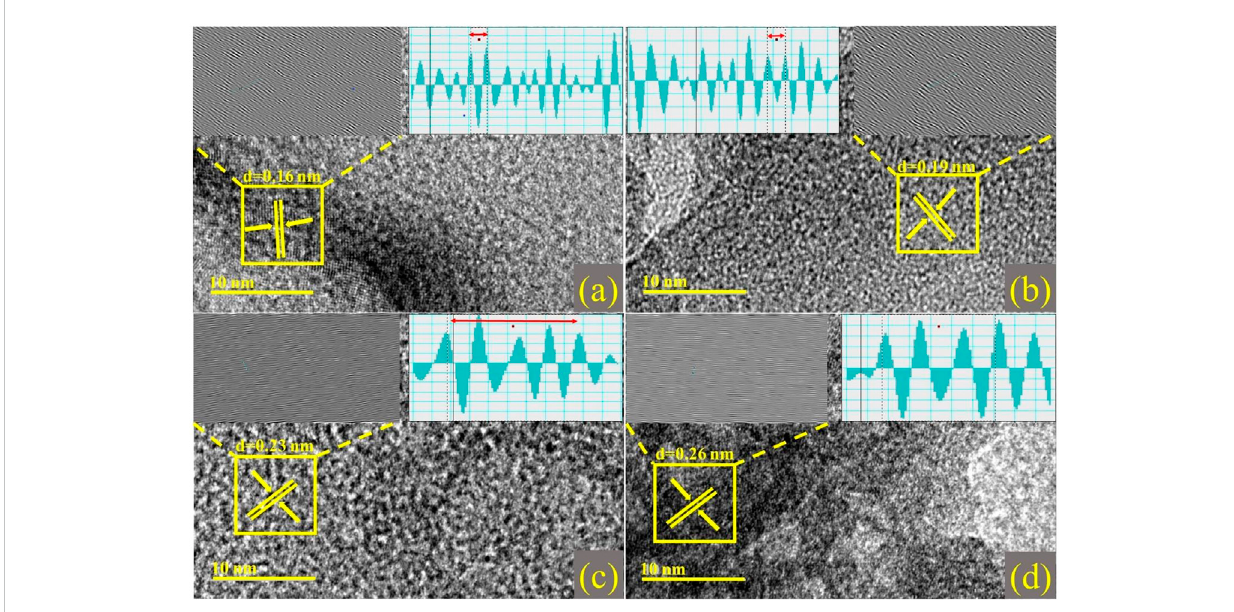
FIGURE 5 d-spacing calculated from HR-TEM images with Inverse Fast Fourier Transform (IFFT) and IFFT image pro fi le of (A) Cr 2 O 3 (B) 2% Sr/Cr 2 O 3 (C) 4% Sr/ Cr 2 O 3 (D) 6% Sr/Cr 2 O 3 .